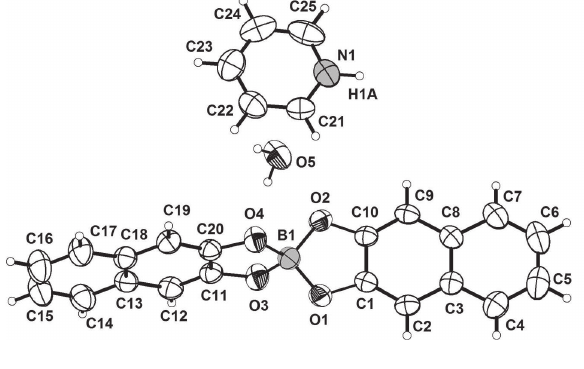
Table 1: Data collection and